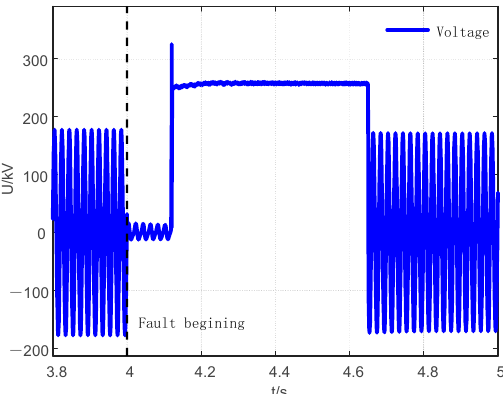
Figure 19. Midpoint voltage waveform of the commutation sequence system based on an